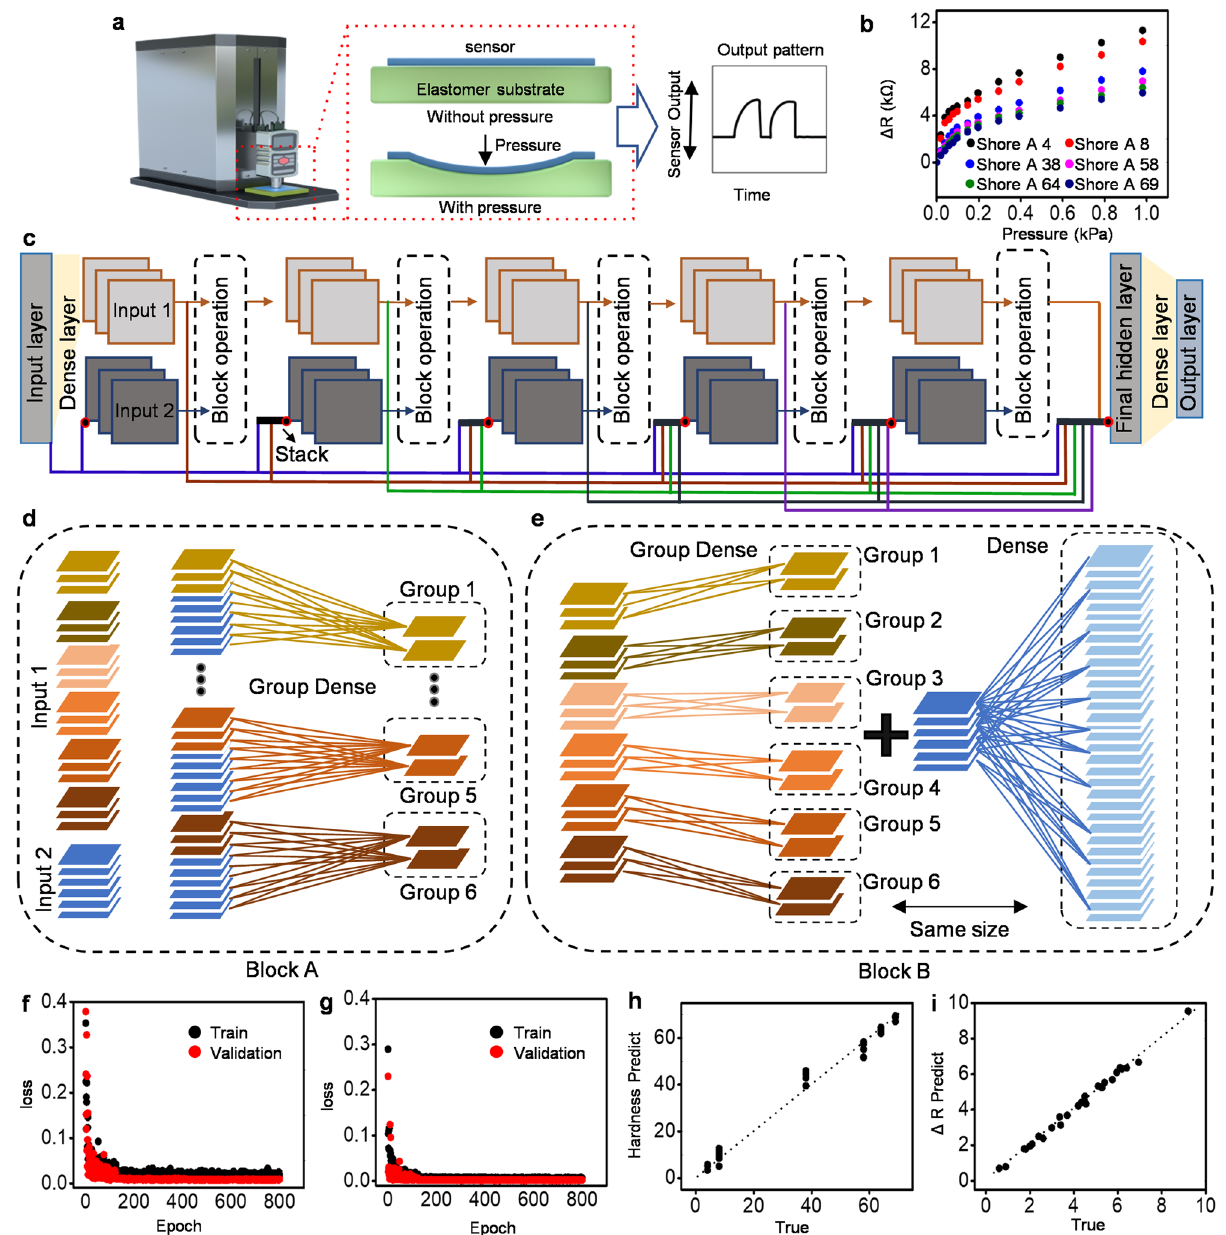
Fig. 3 Deep learning-aided data regression. a Illustration of the sensor deformation as the attached elastomer bends due to external stimuli. b The relationship between the three parameters (i.e., stimulus magnitude, substrate hardness, and sensor output), where separate colors are used for the hardness of the distinct substrates. c The overall structure of our model shows a stacked hierarchy with initial and fi nal dense layers, and fi ve block operations (details shown in c ). Input for block operation: ‘ Input 1 ’ from the feature maps of the previous layer, and ‘ Input 2 ’ from the feature maps of all the preceding layers, except ‘ Input 1 ’ . d Conventional implementation of block operation, where each group consists of divided input 1 and whole input 2 for the group dense operation. e Customized implementation of block operation, where input 1 and input 2 are placed in group dense and general dense operation, respectively. Same size outputs from each operation are added for the fi nal output. f Epoch-loss graph of the training and validation sets for the prediction of substrate hardness from the given sensor output and mechanical stimulus. g Epoch-loss graph of the training and validation sets for the prediction of sensor output from the given hardness and mechanical stimulus. h Scatterplot of the true and prediction value of the test set for substrate hardness. i Scatterplot of the true and prediction value of the test set for sensor